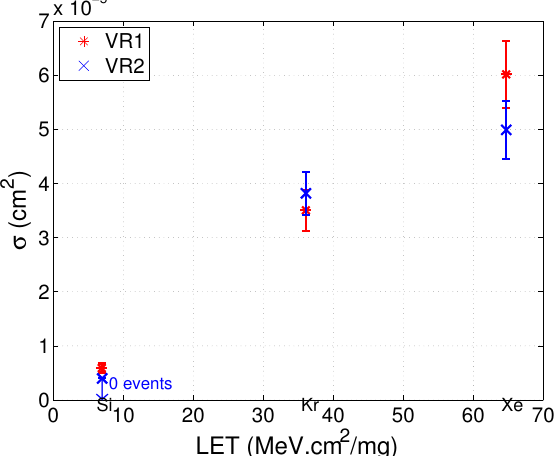
Figure 5. Measured Cross-Section of the two voltage reference circuits (VR 1 and VR 2 ) while exposed to silicon, krypton, and xenon ions.